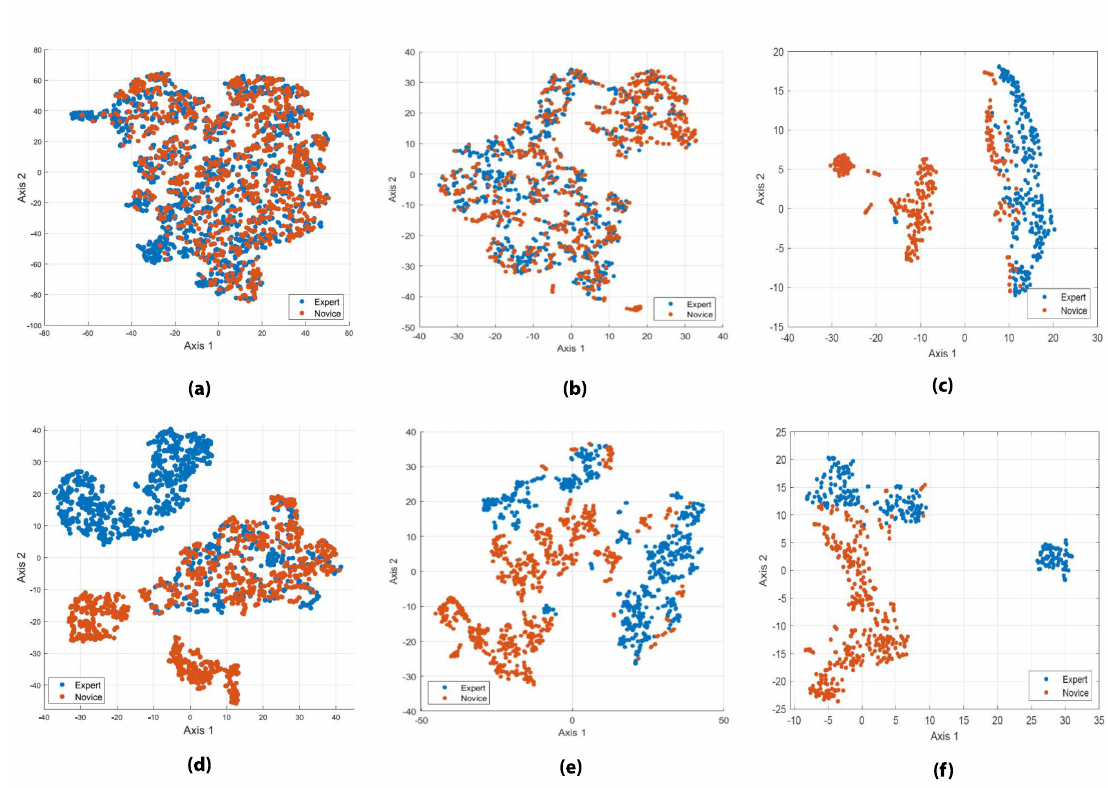
Figure 5. t-Distributed Stochastic Neighbor Embedding (t-SNE) of ( a ) ECG features without baseline correction; ( b ) GSR features without baseline correction; ( c ) Multimodal features without baseline correction; ( d ) ECG features with baseline correction; ( e ) GSR features with baseline correction; ( f ) Multimodal features with baseline